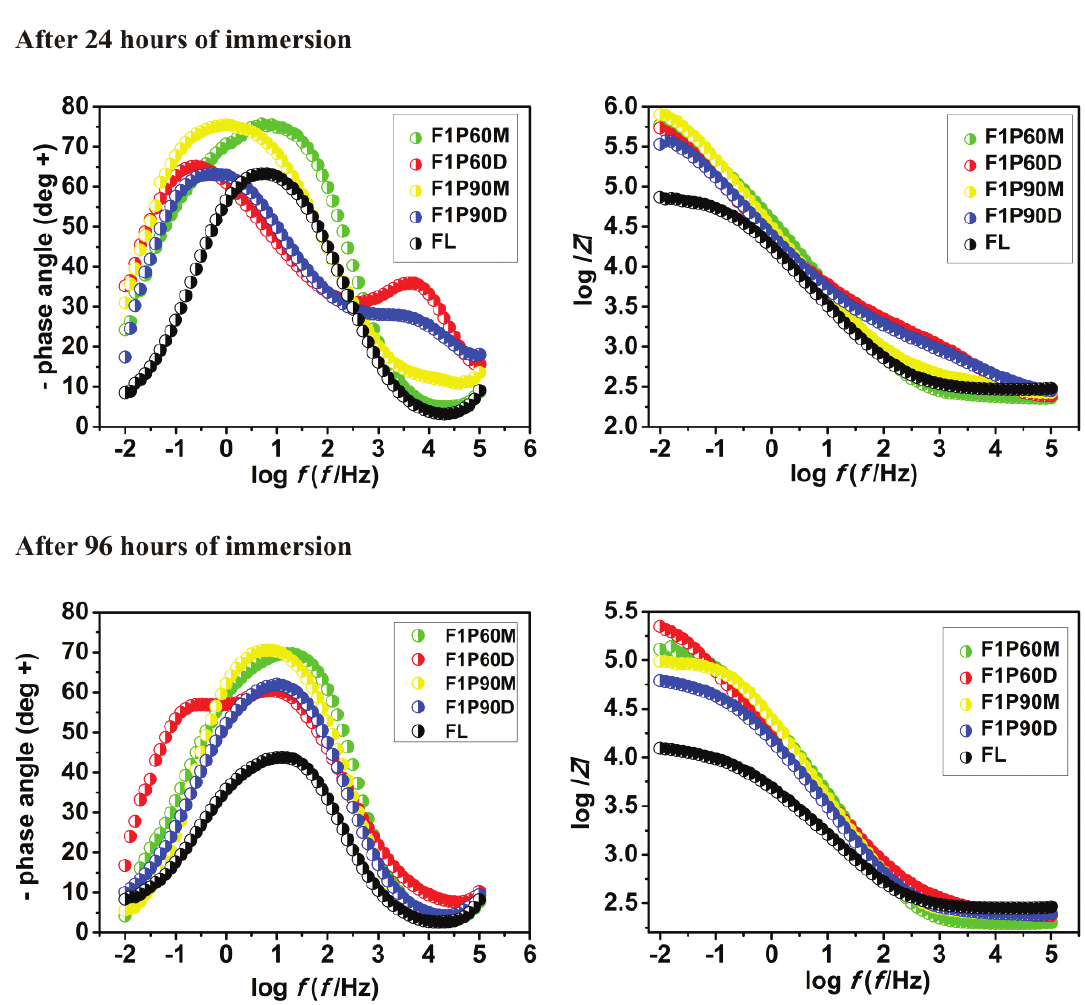
Figure 7. Bode plots obtained for hybrid film coated and uncoated tinplate in 0.05 M NaCl